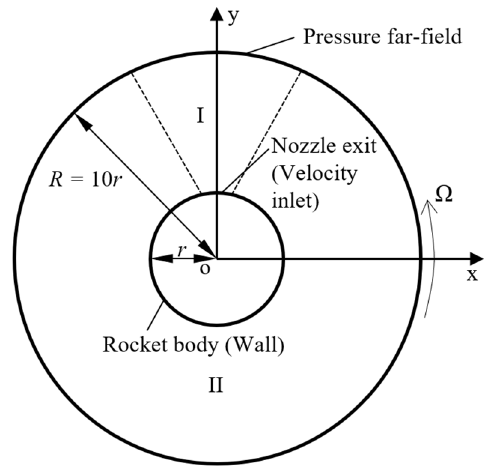
Figure 3. Computational domain and boundary conditions.